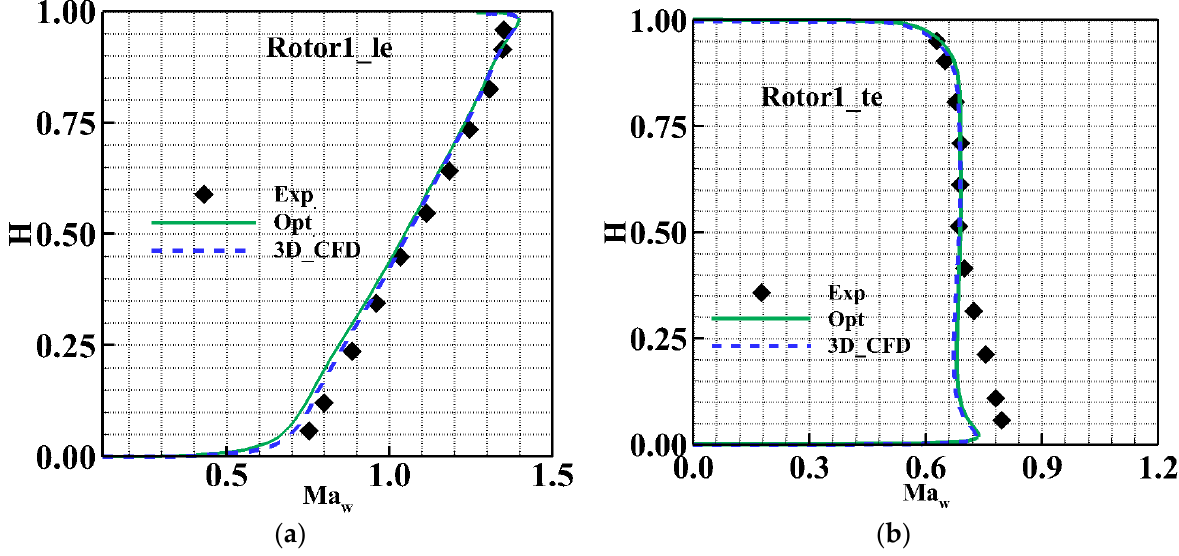
Figure 13. The spanwise distribution of relative Mach number in different axial positions. ( a ) Ro- tor1_leading edge; ( b ) Rotor1_trailing edge.